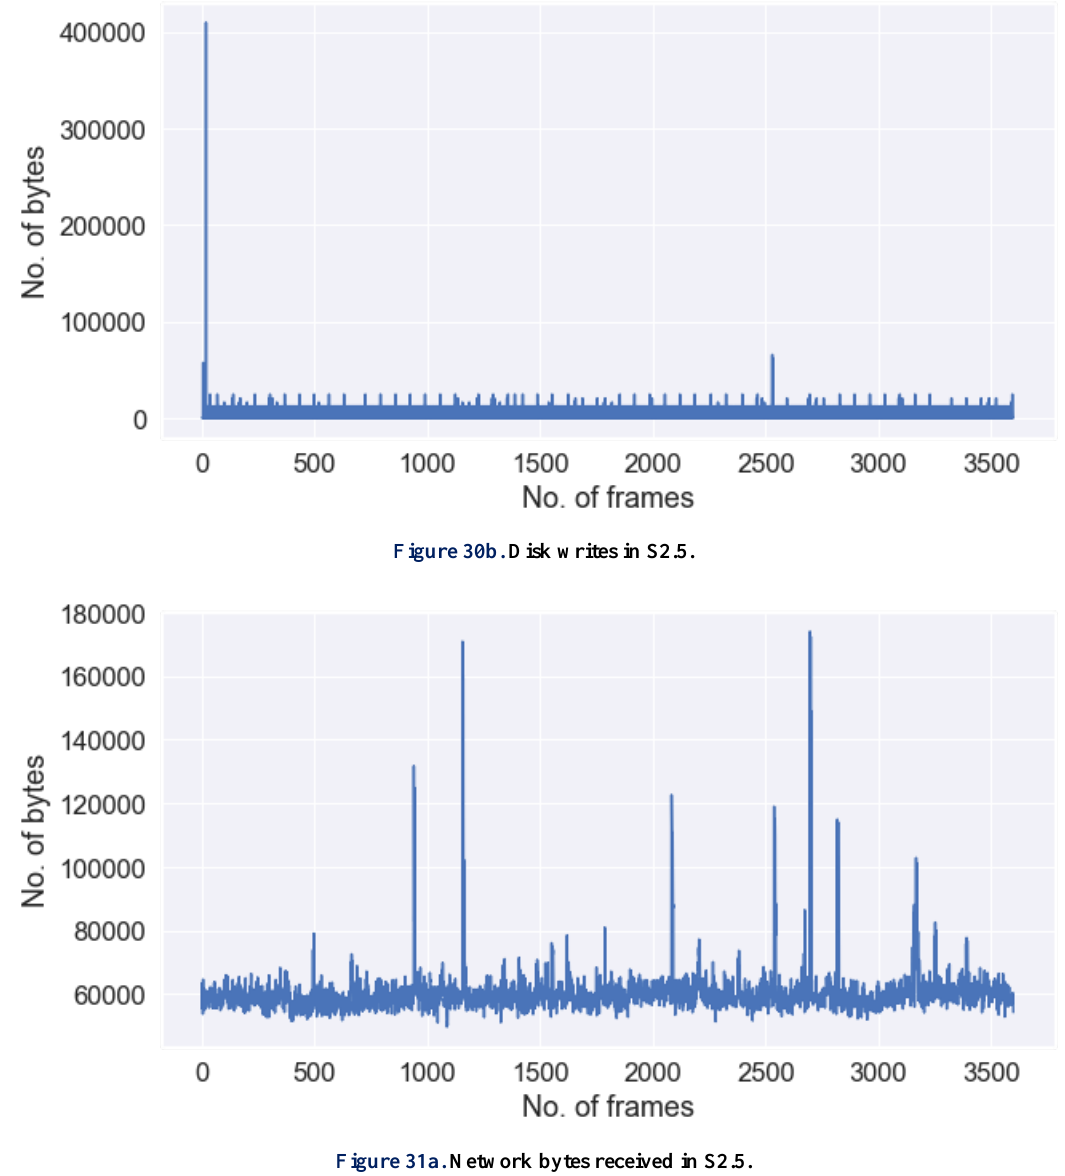
Figure 31a. Network bytes received in S2.5.